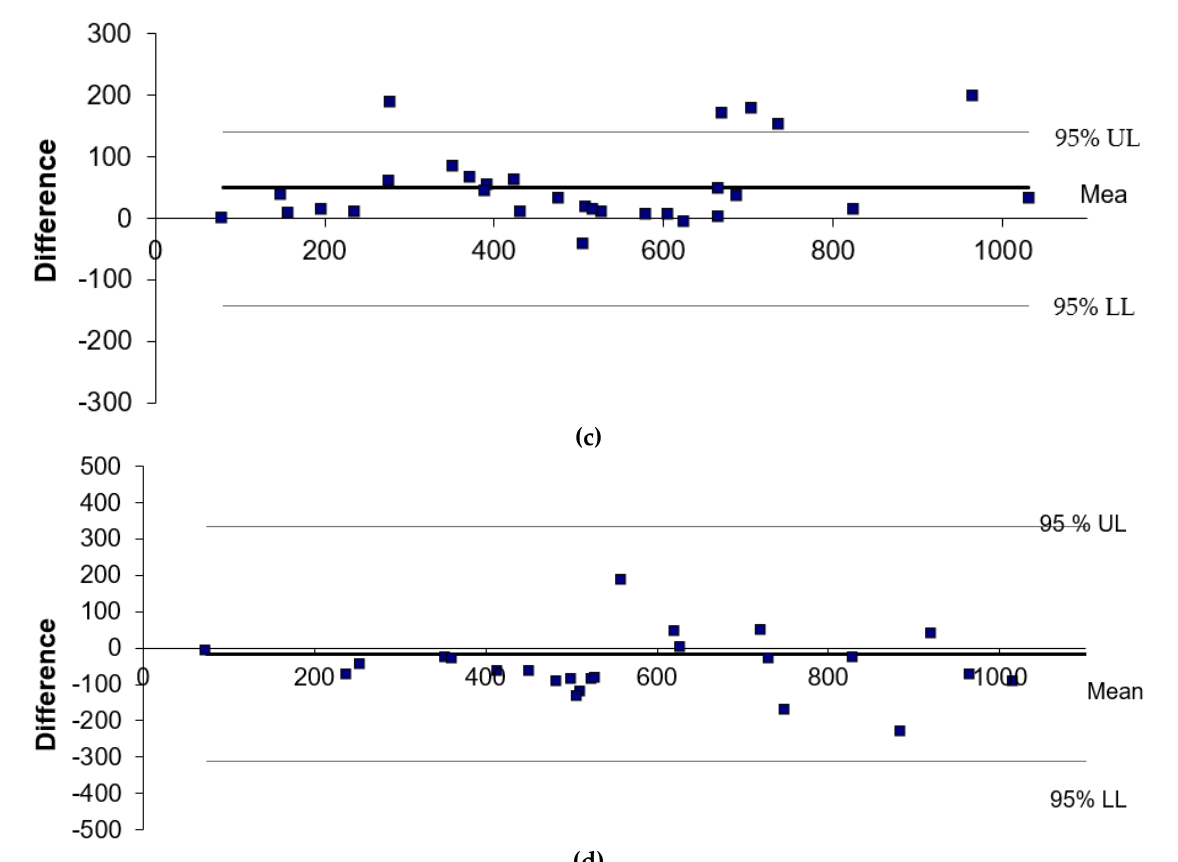
Figure 2. ( a ) Bland–Altman plot for energy intake between Nutricate© and Nutrilog© (kcal/d). ( b ) Bland–Altman plot for protein intake between Nutricate© and Nutrilog© (g). ( c ) Bland–Altman plot for calcium intake between Nutricate© and Nutrilog© (mg/d). ( d ) Bland–Altman plot for iron intake between Nutricate© and Nutrilog© ( µ g/d). The differences between the two methods were calculated as follows: Nutrilog©–Nutricate©. The 95% upper limit (UL) and lower limit (LL) of agreement (SD 1.96) are depicted as a long, dashed line. The full line indicates the mean difference and